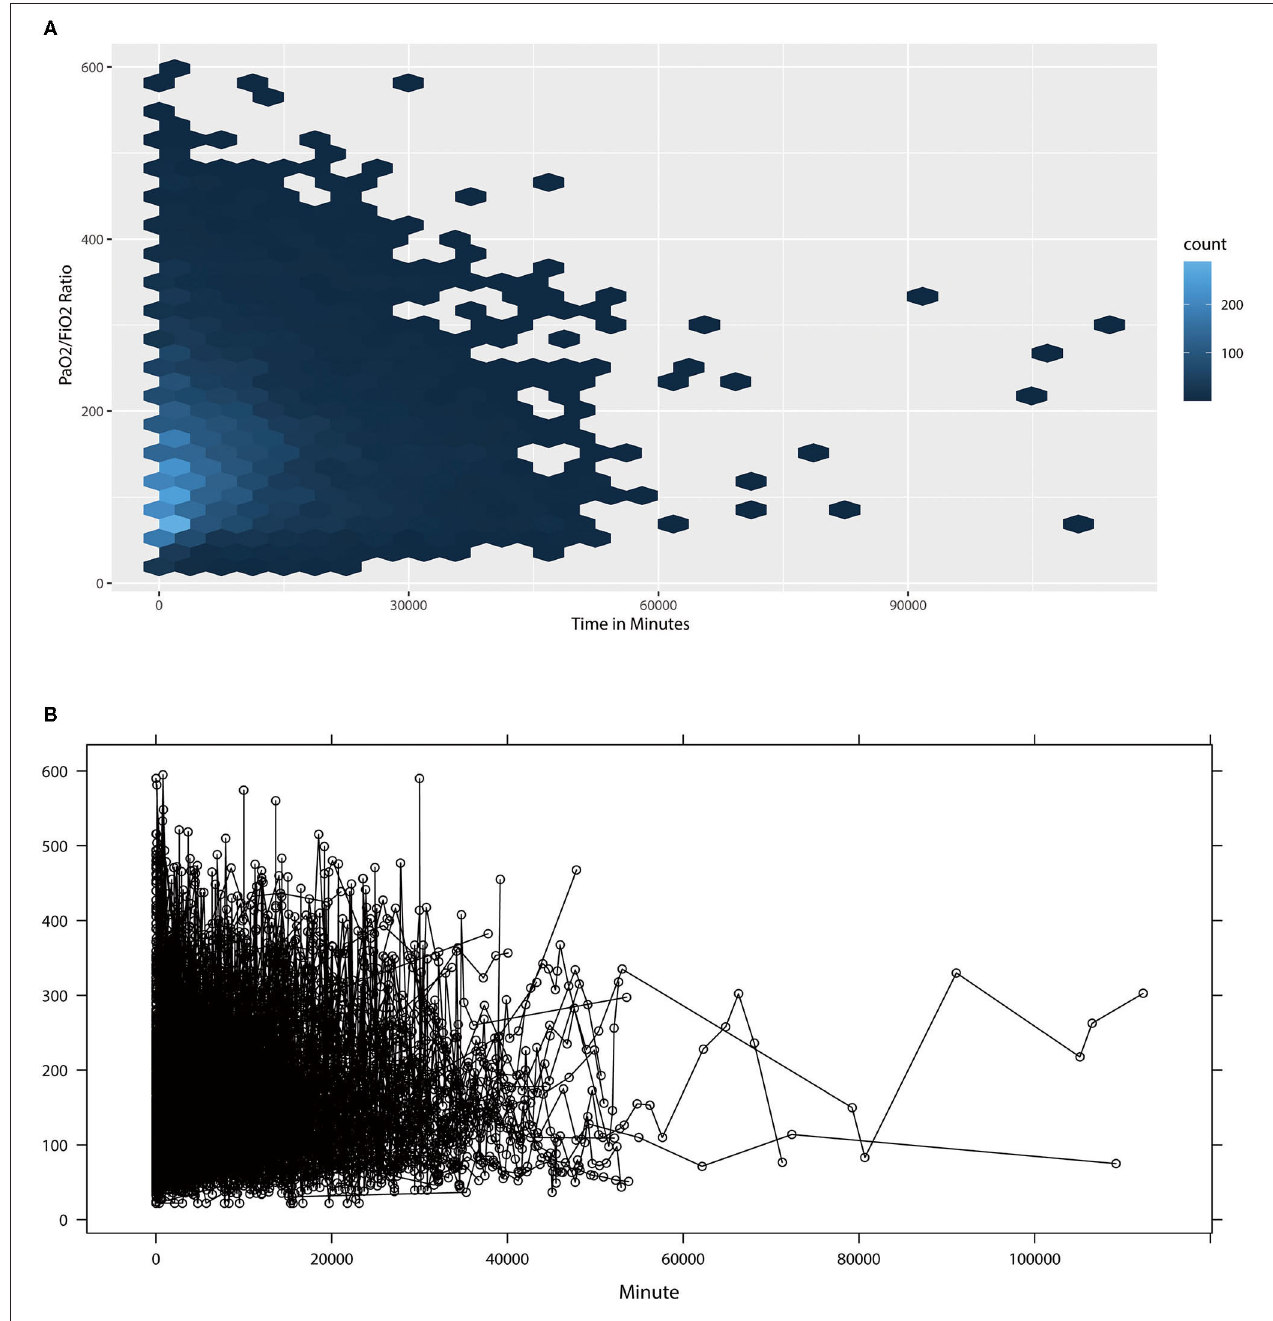
FIGURE 3 | The distribution of PaO2/FiO2 observations (A) and the trajectory (B) of PaO2/FiO2 Observations by Patients in Time Line. (A) showed the density of PaO2/FiO2 ratio observations in time lines. (B) showed then trajectory of PaO2/FiO2 for 508 patients, each line represented the one patient’s trajectory.